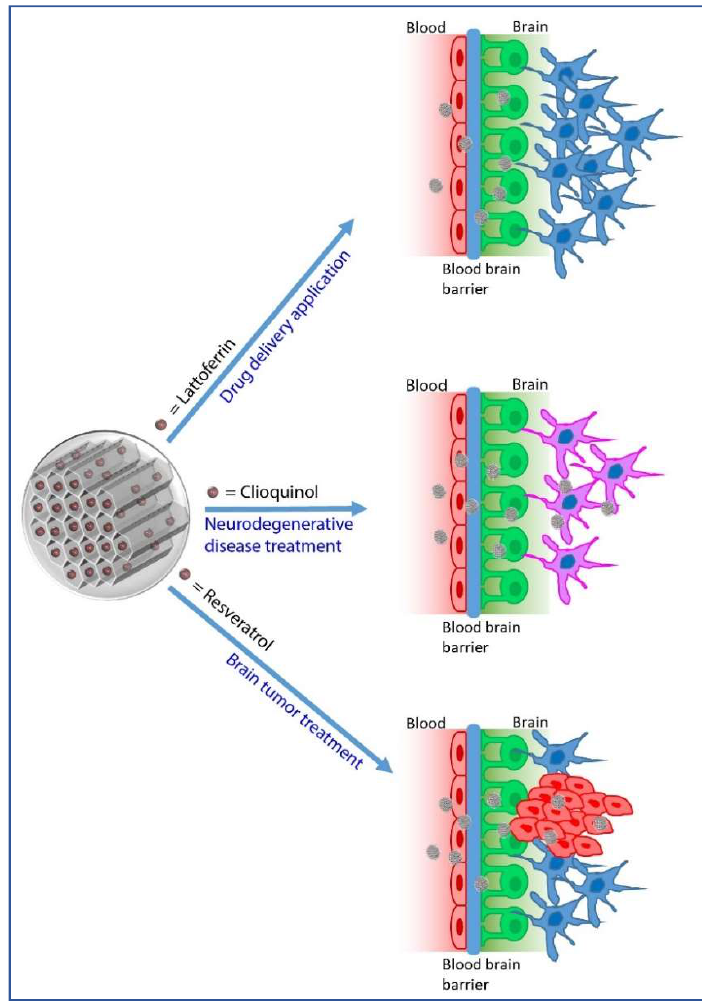
Figure 2. Main applications of MSNs as drug delivery systems for brain related diseases.